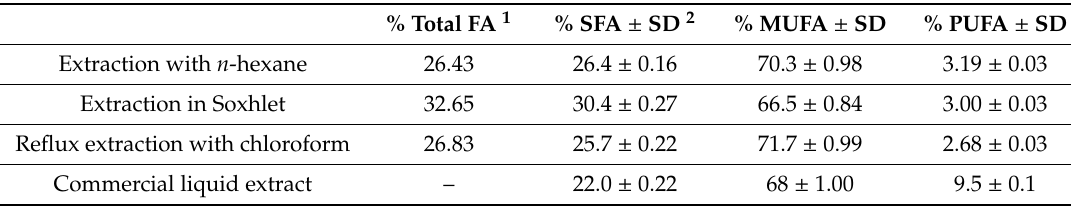
Table 3. Groups of fatty acids from the composition of samples of Ganoderma lucidum obtained with di ff erent extraction processes.